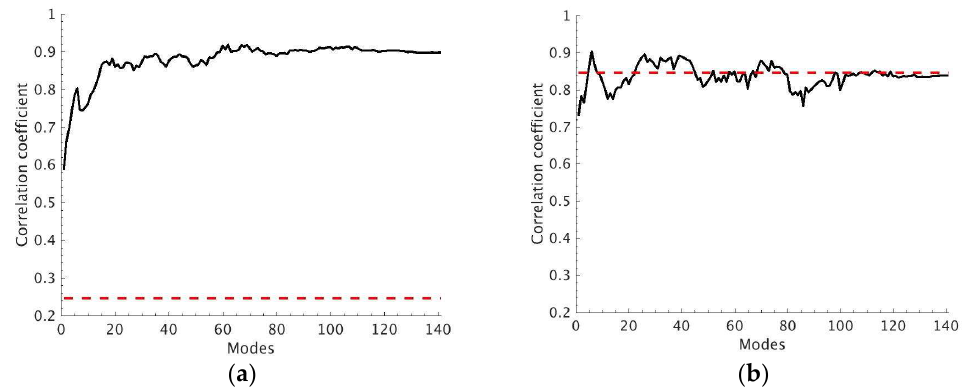
Figure 4. Time series comparisons between the GPS wave buoys (blue lines), POD reconstructions using the leading 6 modes ( n = 6) (green lines), and dispersion filtered reconstructions (red line) for dataset 2. ( a ) are the time series for wave buoy 279; ( b ) are the time series for wave buoy 280; and ( c ) are the time series for buoy 286.